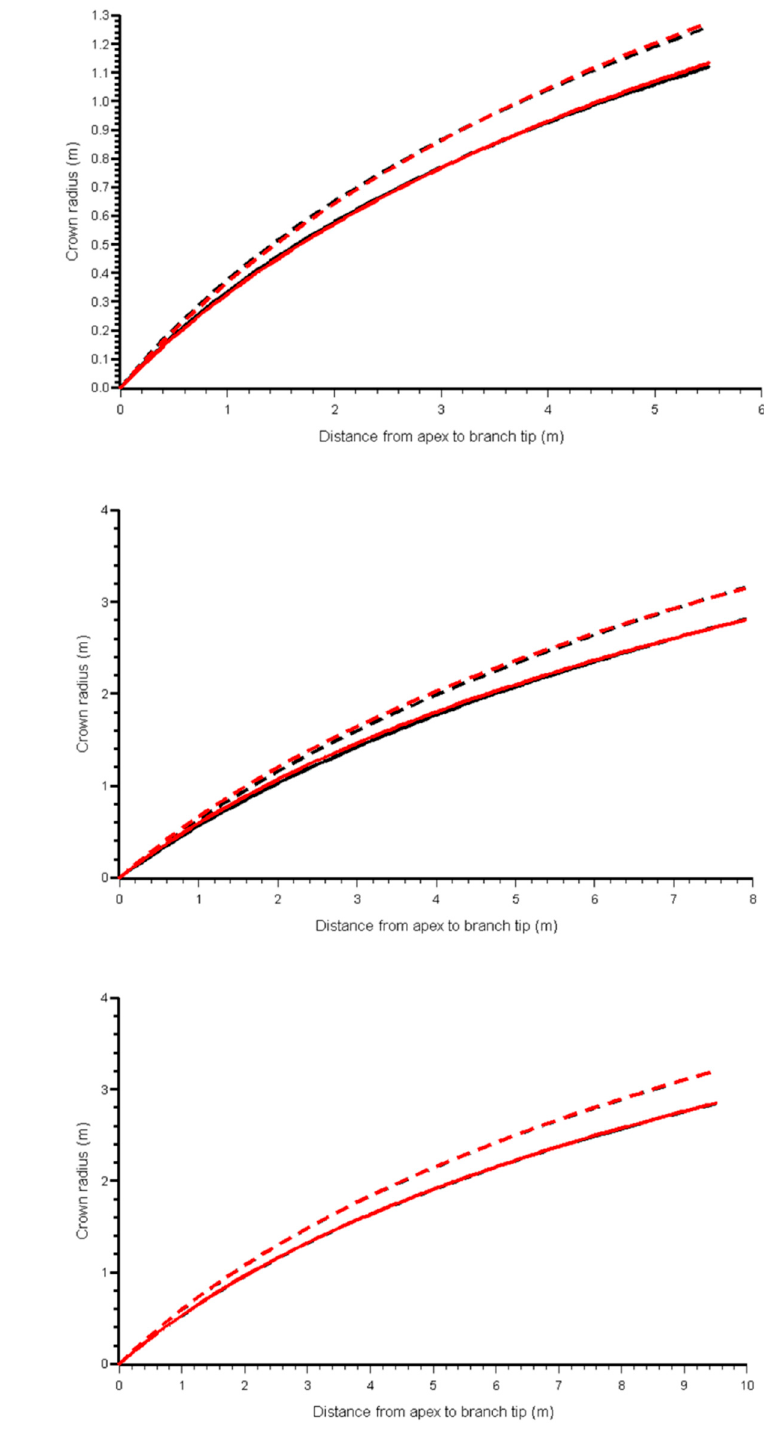
Figure 3. Predicted crown profiles of western hemlocks showing a range of lengths to crown contact ( a ) from the first quartile length to contact, ( b ) from the median and ( c ) from the third quartile, and the predictions of the MP (red) and MB0 (black) models with (solid line) and without (dashed line) reduction factor applied.